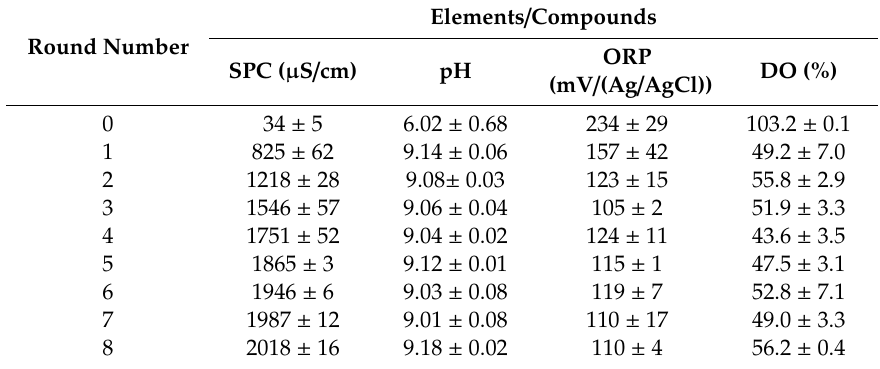
SPC: specific conductance, ORP: oxidation reduction potential, DO: dissolved oxygen.